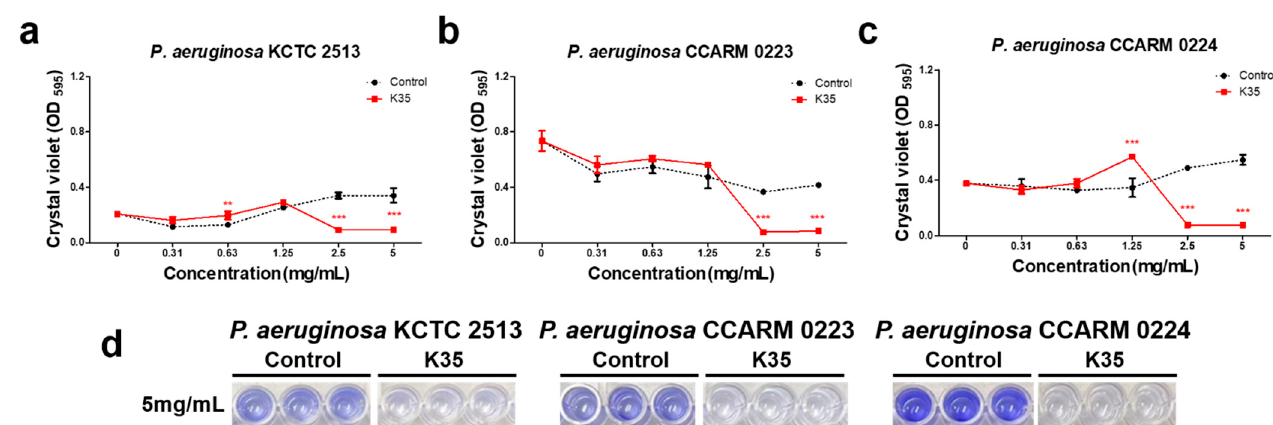
Figure 4. Anti-biofilm-formation activities of P. inopinatus K35 against ( a ) P. aeruginosa KCTC 2513, ( b ) P. aeruginosa CCARM 0223, and ( c ) P. aeruginosa CCARM 0224. ( d ) Representative images of biofilm inhibition by P. inopinatus K35 are shown. Data are presented as mean ± SD of the results from three replicates. ** p ≤ 0.01, *** p ≤ 0.001.